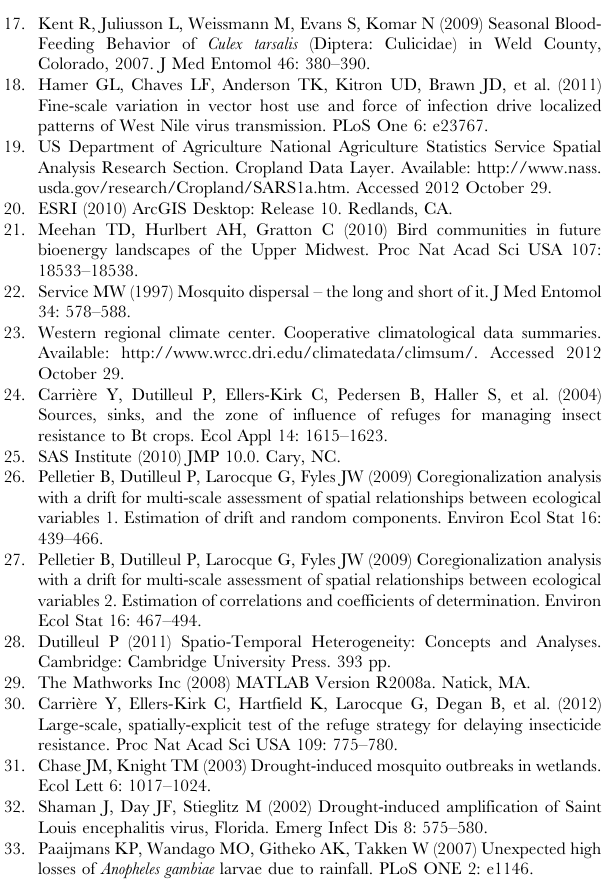
Figure S1 Breeding bird survey sites. Figure S2 R -squared values from logistic regression models.